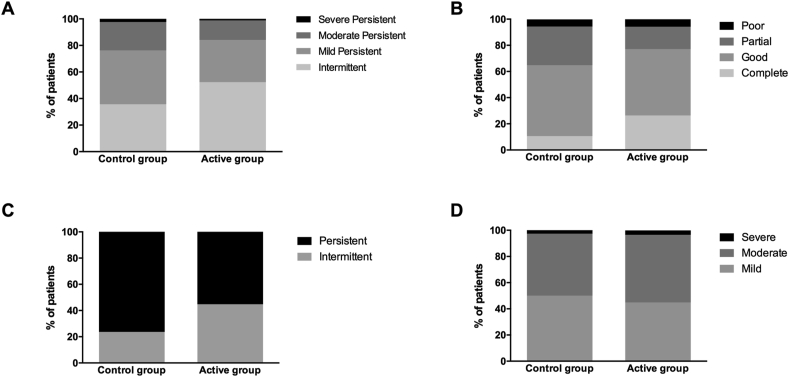
Distribution of patients in the control and active treatment groups according to asthma symptom severity (A) and control (B), rhinitis type (C), and rhinitis severity (D), according to the ARIA and GEMA classifications for rhinitis and asthma, respectively. The percentage of patients in each category is shown in the Y-axis. Chi-square test, P = 0.347, P = 0.179, P = 0.025, and P = 0.858, for A, B, C and D, respectively